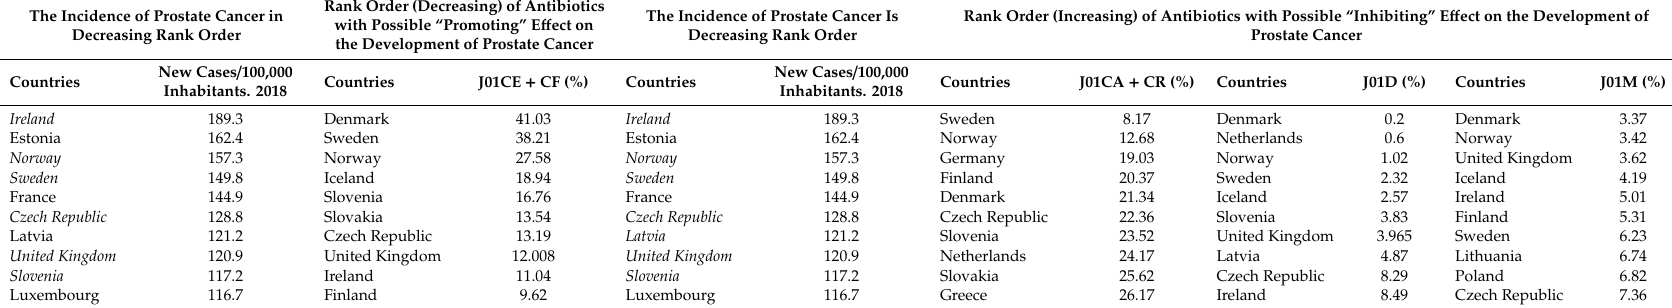
Table 6. Rank order (decreasing) of the incidence of prostate cancer (10 countries) compared to the rank order (decreasing) of antibiotics with suspected “promoter” e ff ect. Of the first ten countries with the highest incidence rate of prostate cancer, six countries can be found among the highest consumption figures of “promoter” antibiotics (bold. italics). Similarly, seven countries with the lowest consumption figures of “inhibitor” antibiotics are among the firs high incidence rates of prostate cancer (bold. italics).